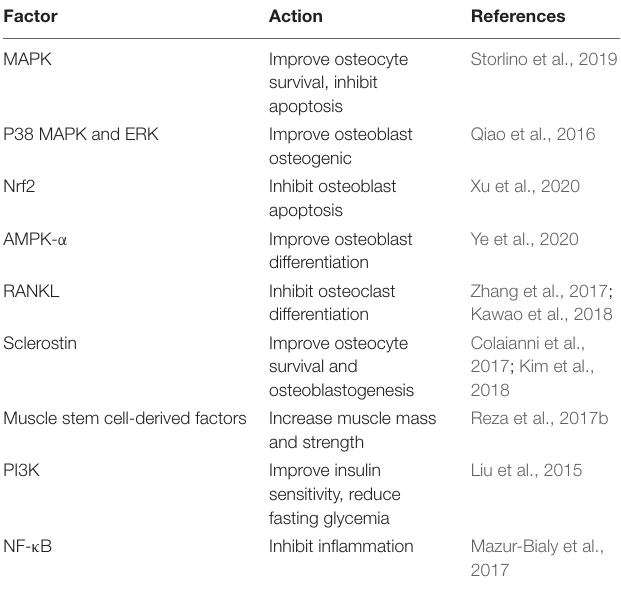
TABLE 1 | Irisin regulates bone metabolism by different factors.